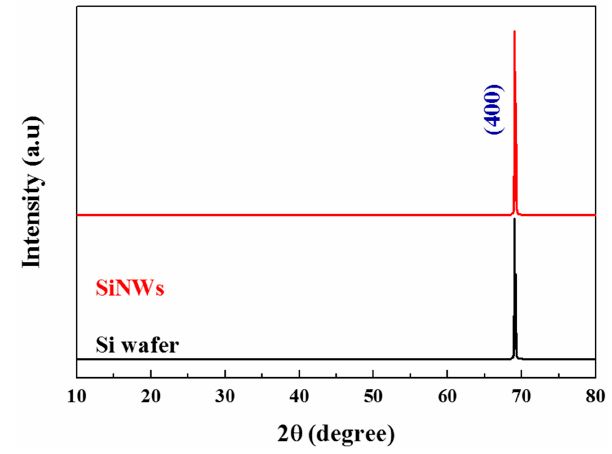
Figure 5. XRD patterns of silicon nanowires and untreated Si wafer.